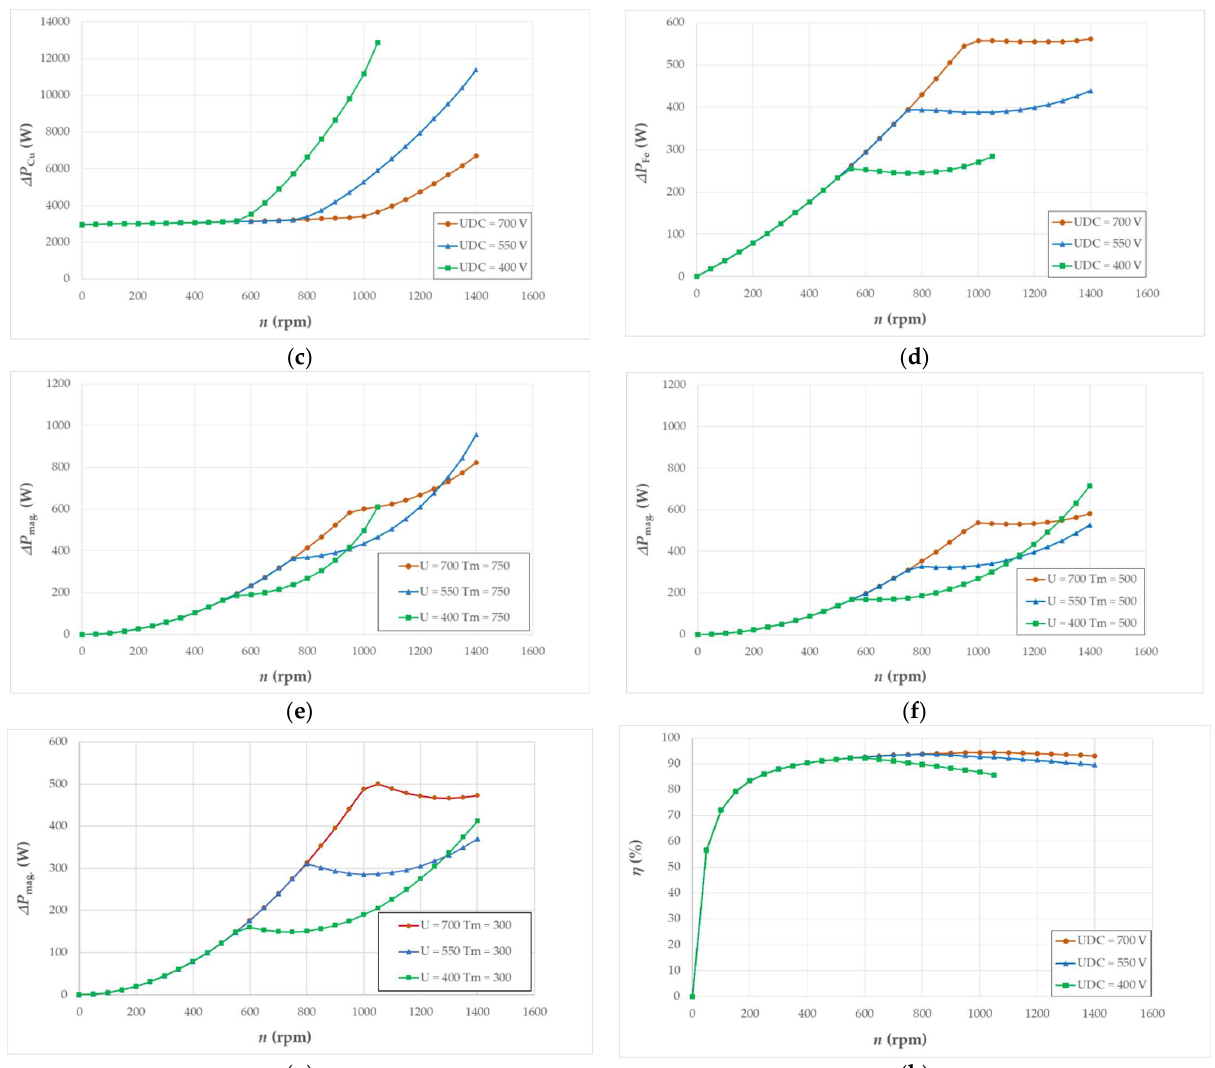
Figure 13. Calculated characteristics of motor operating parameters for three drive supply voltages as a function of rotational speed and torque T m = 750 Nm: ( a ) torque; ( b ) supply current; ( c ) power losses in the winding; ( d ) losses in the stator magnetic core; ( e ) power losses in magnets; ( f ) power losses in magnets for Tm = 550 Nm; ( g ) power losses in magnets for T m = 300 Nm; ( h ) motor effi- ciency .